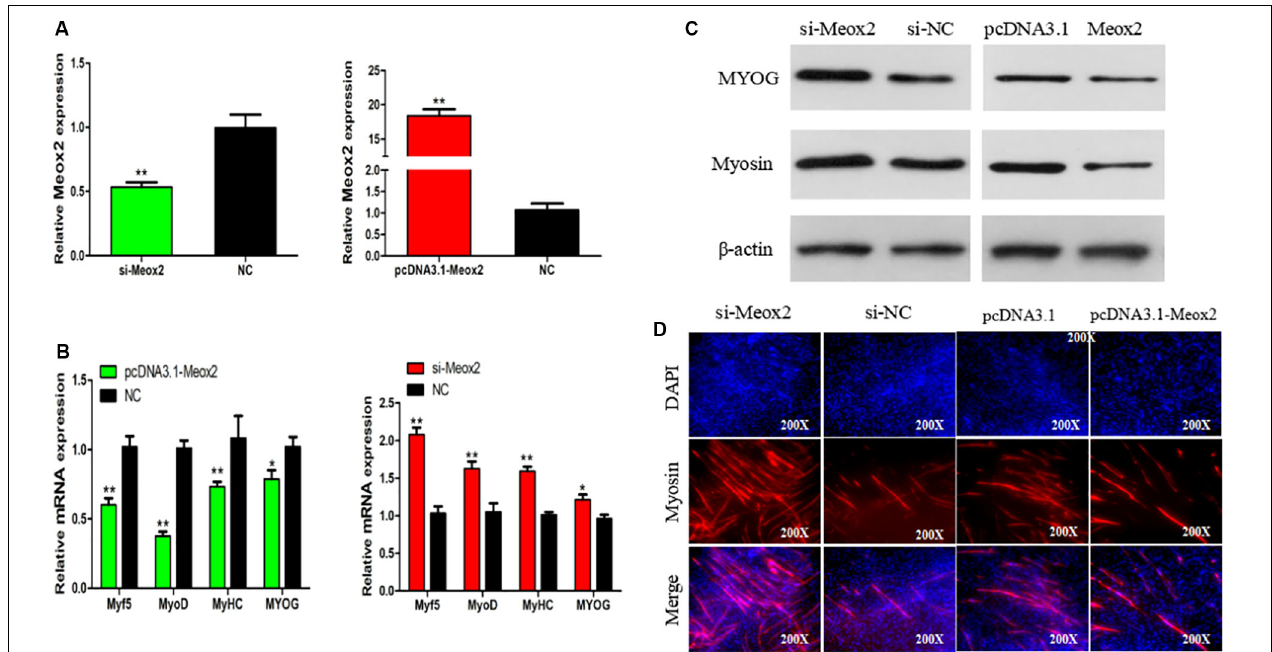
FIGURE 7 | Meox2 inhibits SMSCs differentiation. (A–C) Expression of Meox2, MyoD, MyoG, MyHC, and Myf5 mRNA and the protein abundance of MyoG and Myosin in SMSCs transfected with si-Meox2, pCD3.1-Meox2, or negative control. (D) Representative images of immunofluorescent staining of differentiated SMSCs (200 × ). Myosin: red, a molecular marker of myogenesis; DAPI: blue, cell nuclei; Merge: the fusion of SMSCs into the primary myotubes. Data are expressed as mean ± SEM ( N = 3). * P < 0.05; ** P < 0.01 vs. NC.